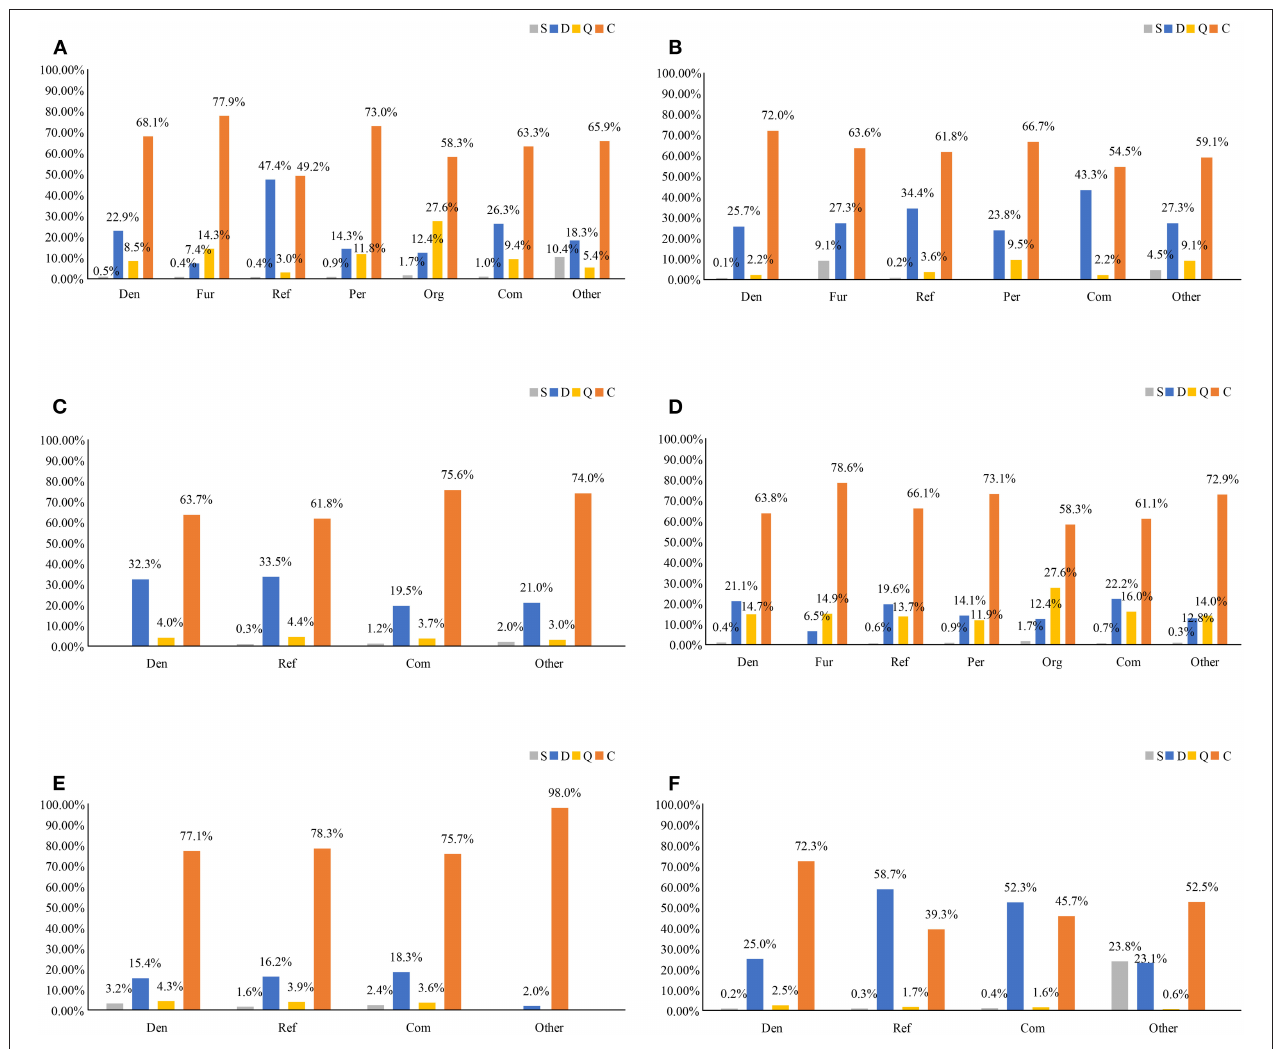
FIGURE 4 | Comparison of the number and proportion of comments for the SDQC stances corresponding to different debunking methods in (A) overall, (B) News rumor, (C) Jiangsu rumor, (D) PatientZero rumor, (E) Russia rumor, and (F) Car rumor. Other: all non-debunking methods with SDQC stances on rumors.